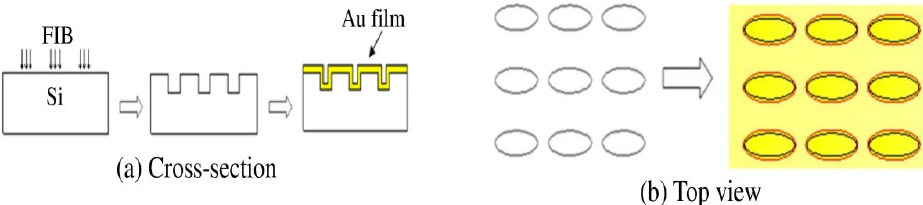
Figure 28. Schematic images of the process of Focused Ion Beam (FIB) pre-milling with the following thermal evaporation: ( a ) Cross section of the nanostructures before and after thermal evaporation; ( b ) top view of the nanostructures. Reprinted with permission of [94].